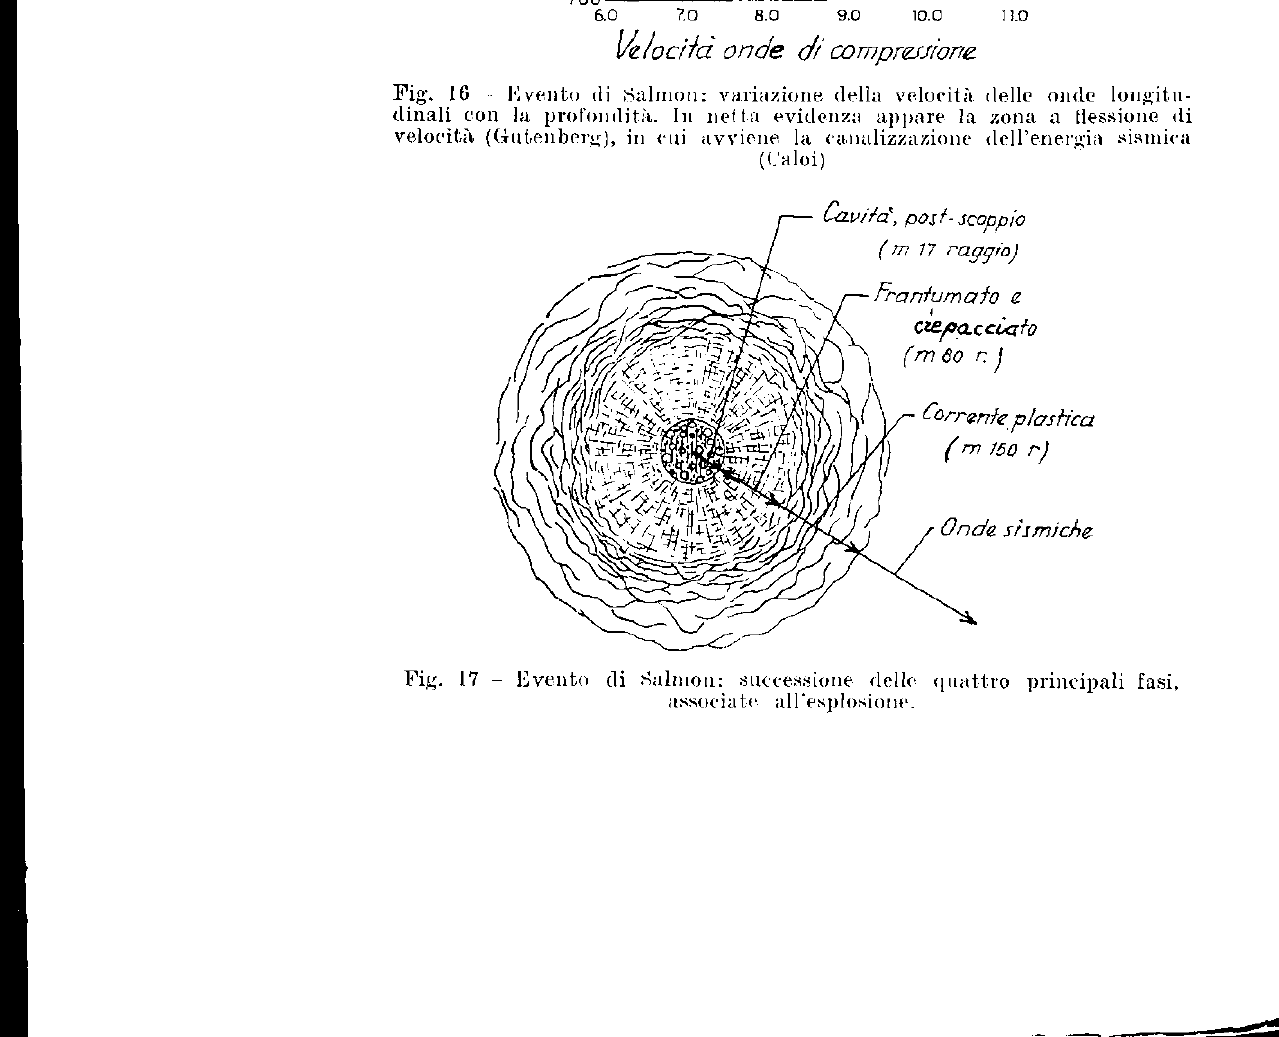
Fig. 17 - Evento di Salmon: successione delle quattro principali fasi, associate